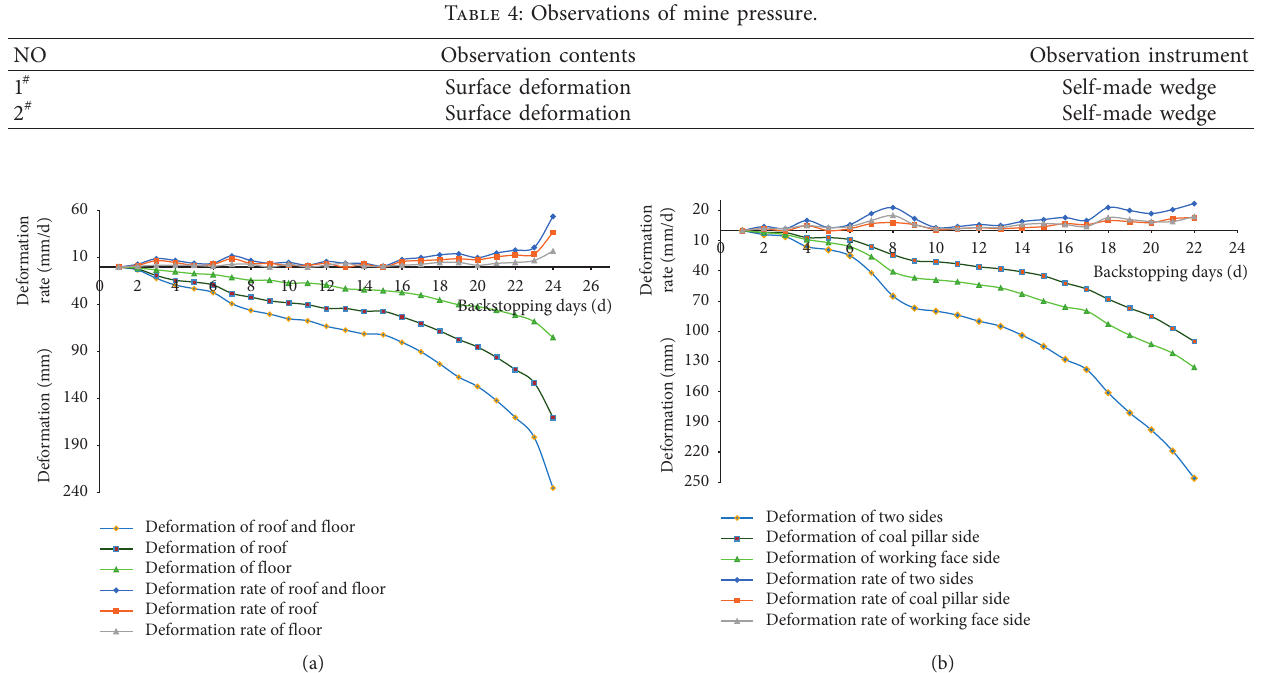
Figure 3: The entry deformation curve. (a) The deformation rate of roof and floor. (b) The deformation rate of two